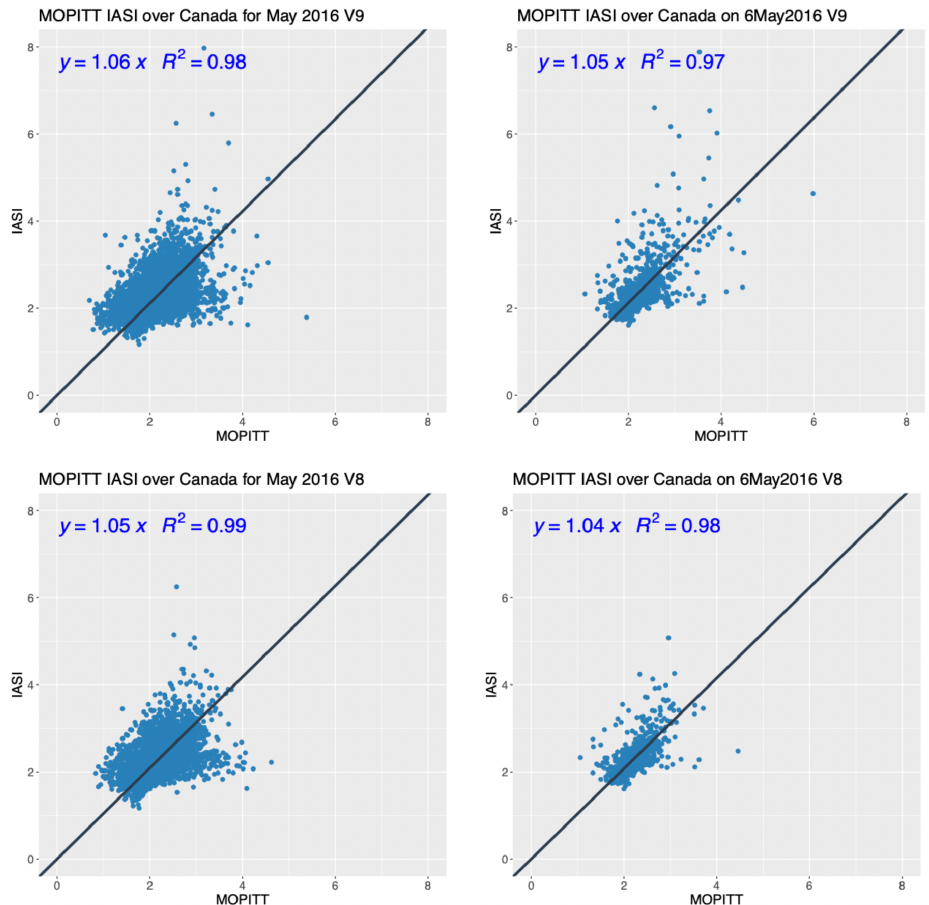
Figure 11. Scatter plots of the IASI and MOPITT CO retrievals in 10 18 moleculescm − 2 , for 6 May 2016 and the monthly averaged May 2016. The correlation coefficient and the regression slope are